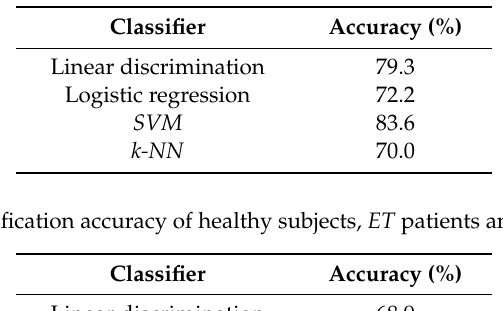
Table 2. Classification results of ET patients and CD patients.